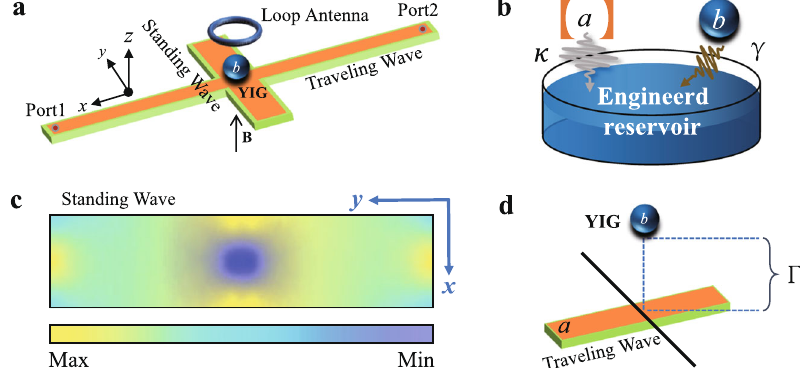
Fig. 1 Sketch of the open cavity magnonic system. a The yttrium-iron-garnet (YIG) sphere is placed inside a cross-line cavity which supports both standing wave and traveling wave. The entire experimental device is placed inside a uniform magnetic fi eld, at the same time in the 20 mK temperature environment. b Both the cavity and the YIG sphere are coupled to the same dissipative environment. c The magnetic fi eld strength and magnetic fi eld distribution of the standing wave cavity. d The dissipative coupling strength can be adjusted by changing the distance between the YIG sphere and the cross-line circuit. The traveling wave is represented by a black